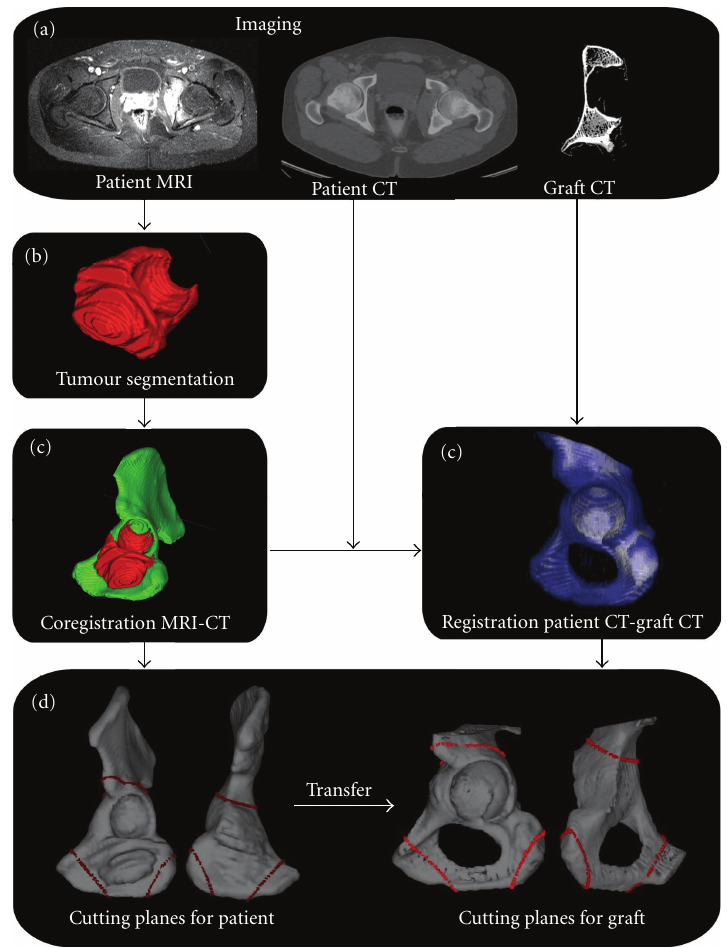
Figure 1: (a) Preoperative imaging workup of the patient consisted of MRI and CT of the pelvis. A CT of the allograft (iliac bone) was also obtained. (b) The tumor is segmented on the MRI slices. (c) The MRI and CT are coregistered. The CT of the patient and of the allograft are registered. (d) The target planes (red lines) are preoperatively defined by locating the planes with respect of a safe margin from the tumor. The planes coordinates are transferred to the